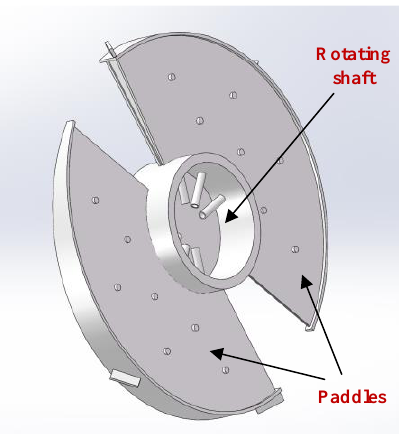
Figure 1. Schematic of the paddle dryer.